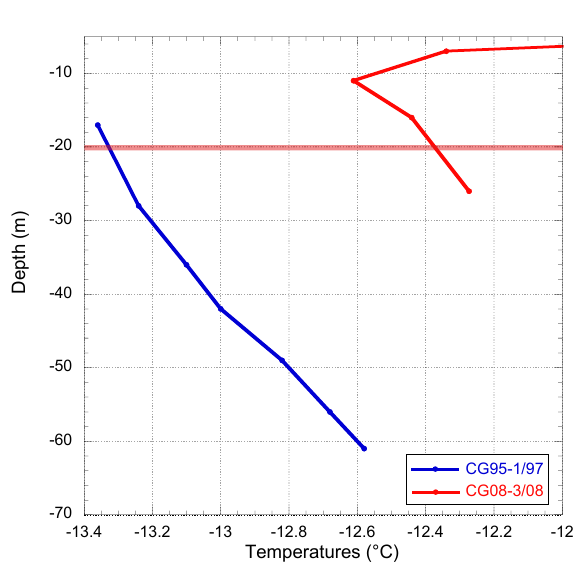
Fig. 7. Temperatures measured in SJ99-10/99 (Suter 2002) at Seser- joch, compared with the new measurements at